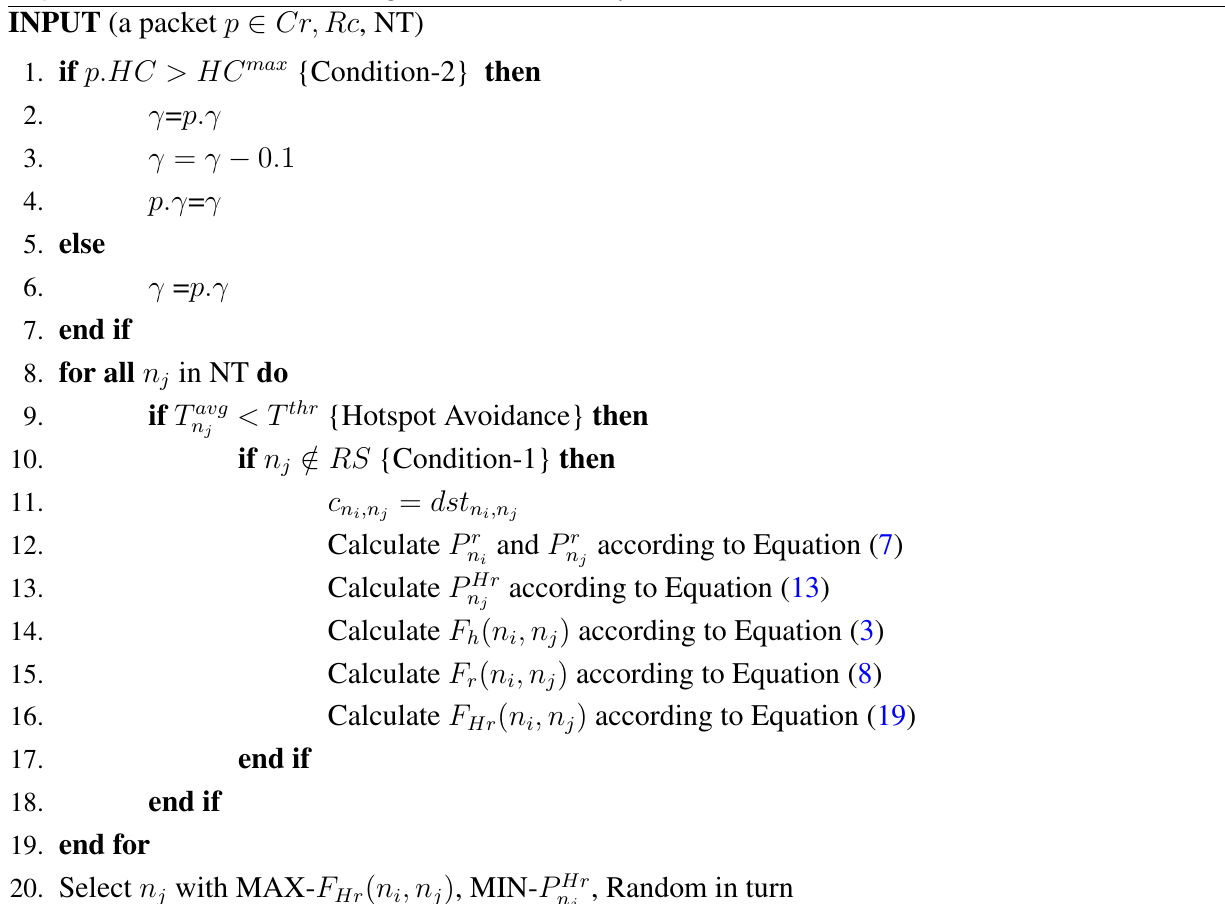
Algorithm 2 Route selection algorithm at reliability